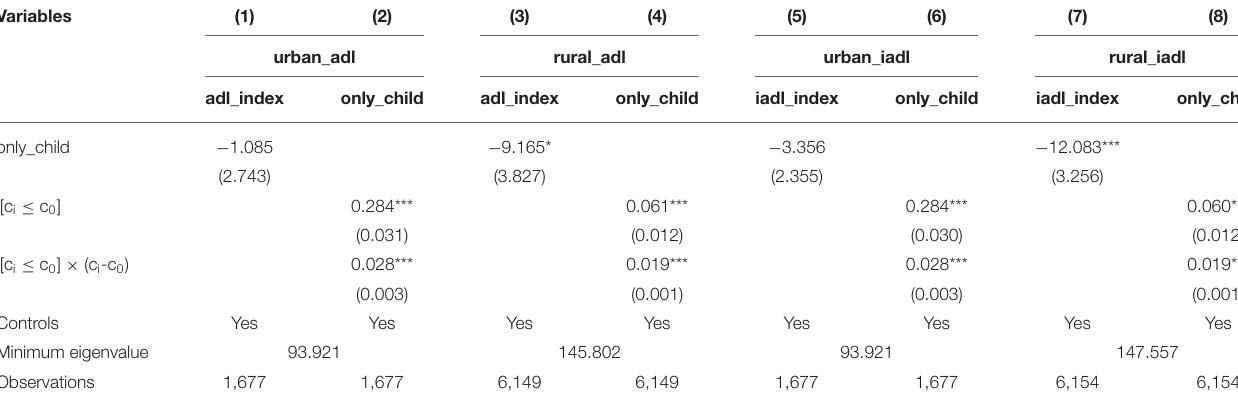
TABLE 2 | The health effect of having only one child. Variables